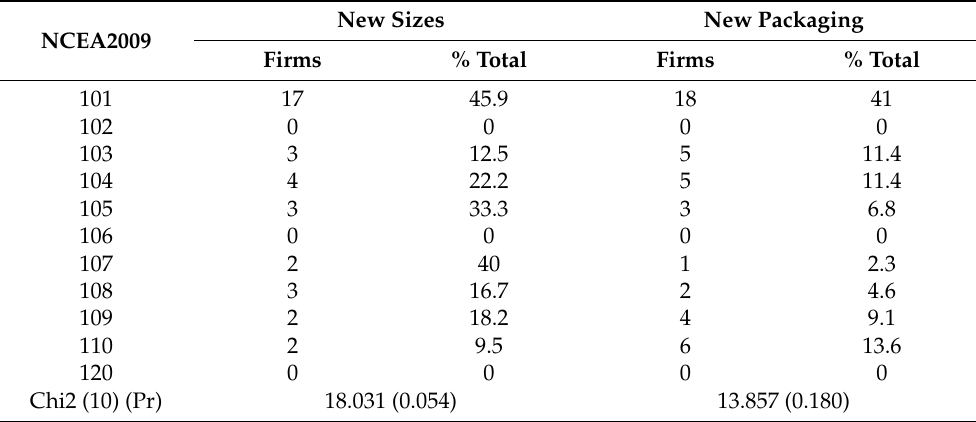
Table 10. Changes in the format of the products according to the branch of activity.